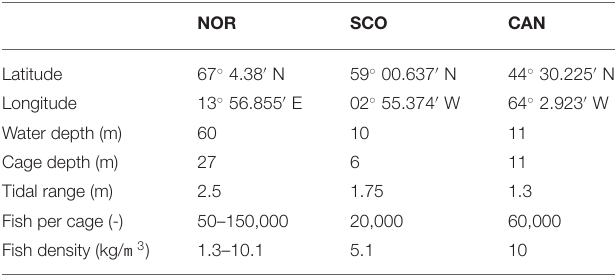
TABLE 1 | Summary metrics for the three sites describing location, water depth, cage depth, average tidal range, number of fish per cage, and fish